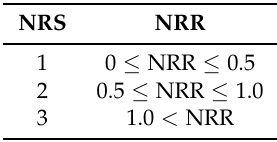
Table 1. NRS Value Based on